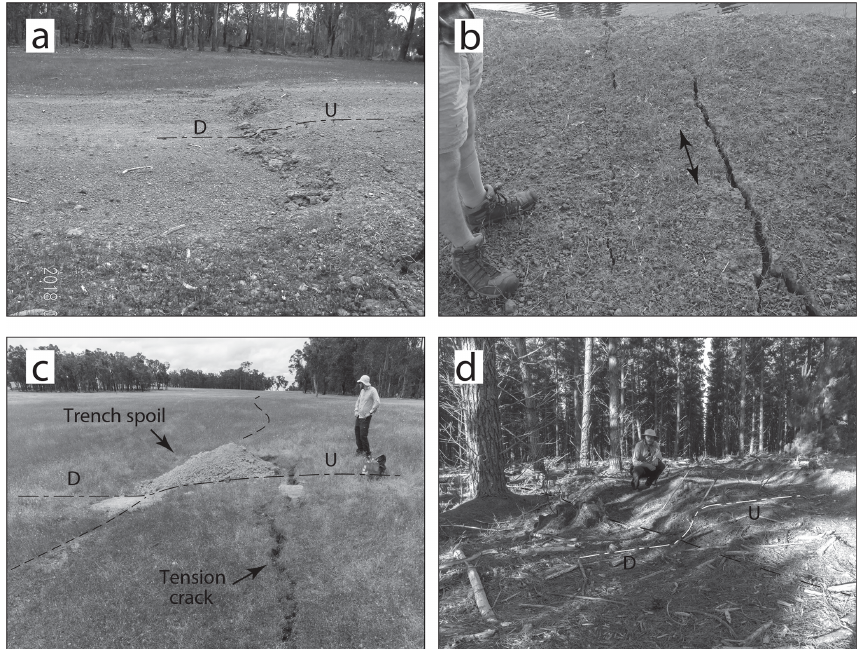
Figure 4. Photographs of the surface rupture: (a) 13cm high scarp crossing farm track. Photo taken by Roger Hearn on 27 September 2018. Looking north (479101mE, 6190727mN); (b) east-trending tension fissures relating to lateral spread into a farm dam (479588mE, 6192126mN); (c) 40cm high scarp and hanging wall tension fissure at the hand trench location (see Fig. 5). Looking north (479285mE, 6191496mN); (d) 40cm high scarp in pine plantation. Looking northeast (479112mE, 6190422mN). GD94/MGA50.